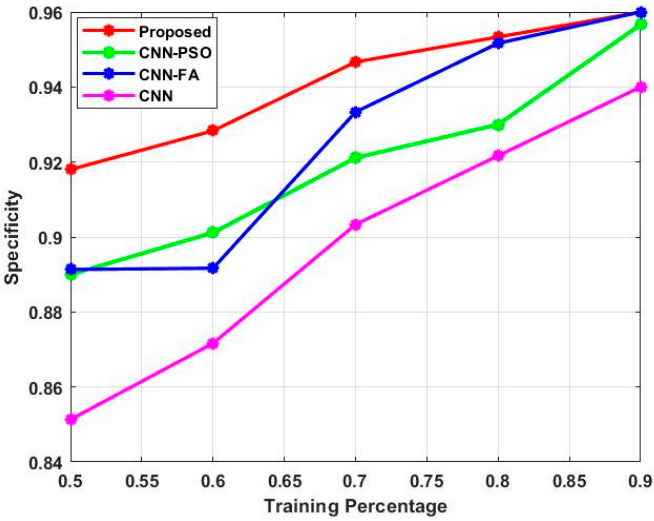
Figure 6. Specificity.